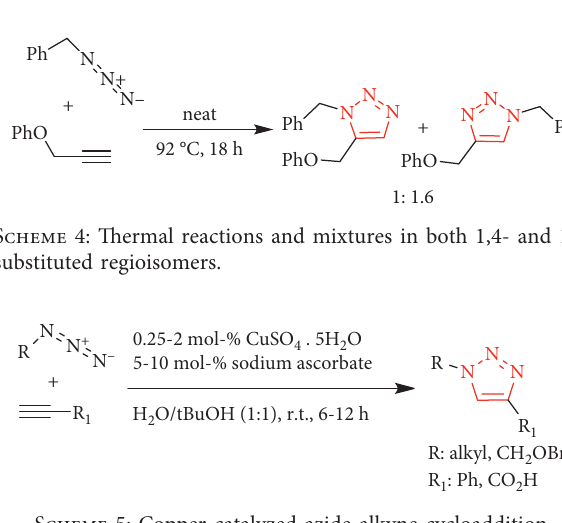
Figure 1: Diagram of identification of the provided content in this review.